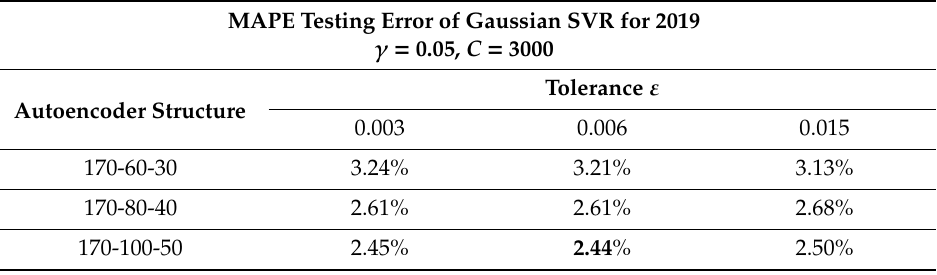
Table 4. Mean MAPE errors for all the weeks of 2019, using SVR network as the